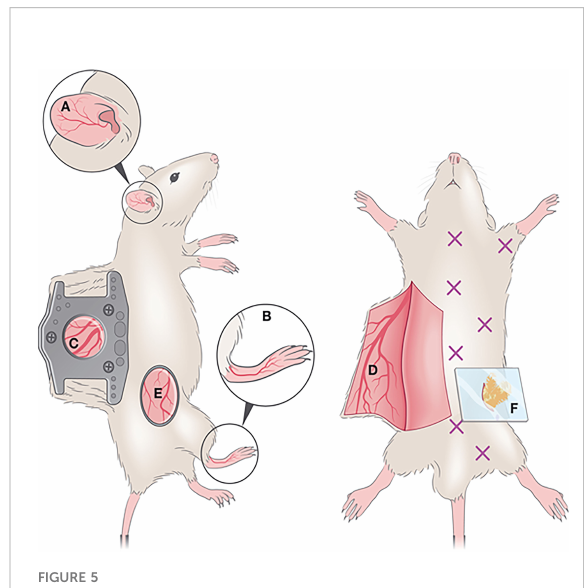
FIGURE 5 Optical windows and imaging chambers for skin and adipose tissue visualization by IVM. Non-invasive methods include (A) ear pinna imaging and (B) foot-pad imaging. A semi-invasive method (C) includes the dorsal skinfold chamber, which requires the surgical implantation of two titanium or polymer frames that can hold a ring with a glass coverslip through which imaging is performed. An invasive method is the generation of a skin fl ap (D) , whereby a skin fl ap is generated, exposing a large imaging area. This procedure is invasive and terminal. A less